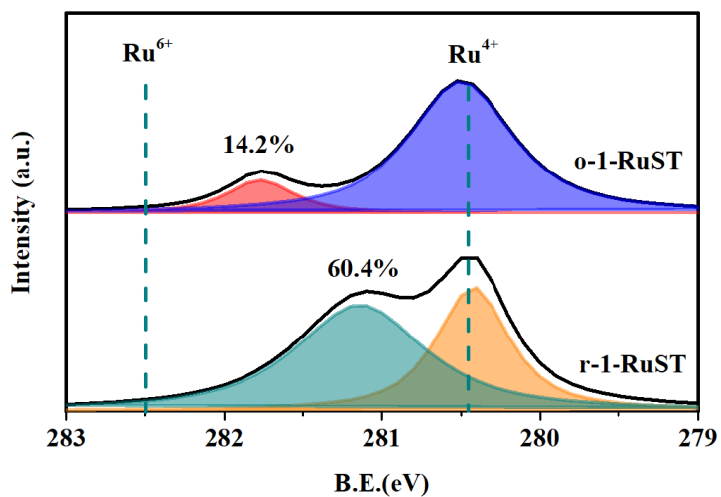
Figure 5. XPS data of Ru 3d for the c-1-RuST sample and o-1-RuST sample. The peak positions of Ru 4+ and Ru 6+ binding energy and the ratio of Ru n+ (4 < n < 6) to the total number of Ru species in the two samples are also marked in the Figure.